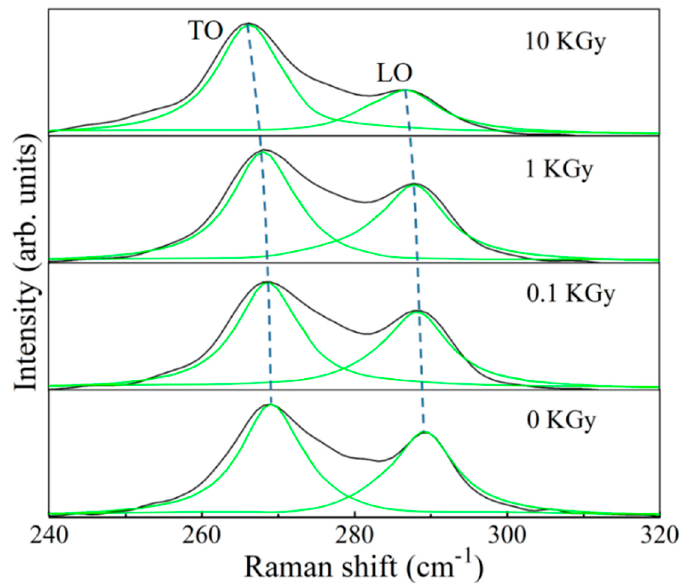
Figure 3. The Raman spectra of the Si-doped GaAs under different γ -radiation doses (0, 0.1, 1 and 10 KGy) along with the spectrum of the undoped GaAs substrate (black line) as a